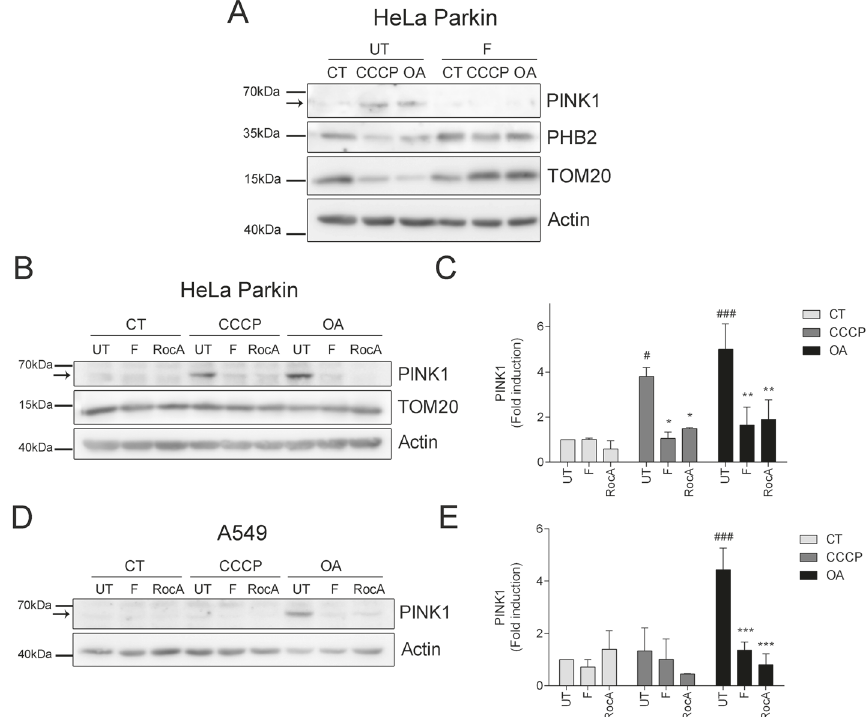
Fig. 4 Fluorizoline prevents PINK1 stabilization in the OMM. HeLa Parkin cells (CT) were treated for 16 h with 10 μ M CCCP or 1 μ M oligomycin/1 μ M antimycin A (OA) in the absence (UT) or presence of 10 μ M fl uorizoline (F) ( A ). HeLa Parkin ( B , C ) and A549 ( D , E ) cells were treated for 6 h with or without 10 μ M CCCP or 1 μ M oligomycin/1 μ M antimycin A (OA) in the absence (UT) or presence of 10 μ M fl uorizoline (F) or 500 nM rocaglamide A (RocA). Protein levels from whole-cell lysates were analyzed by western blot and actin was used as loading control. These are representative images of three independent experiments ( A, B, D ). PINK1 protein expression levels were quanti fi ed. Mean ± SEM ( n = 3 independent experiments) ( C, E ). * p < 0.05, ** p < 0.01, *** p < 0.001 UT versus F or RocA-treated cells; # p < 0.05, ### p < 0.001 CT